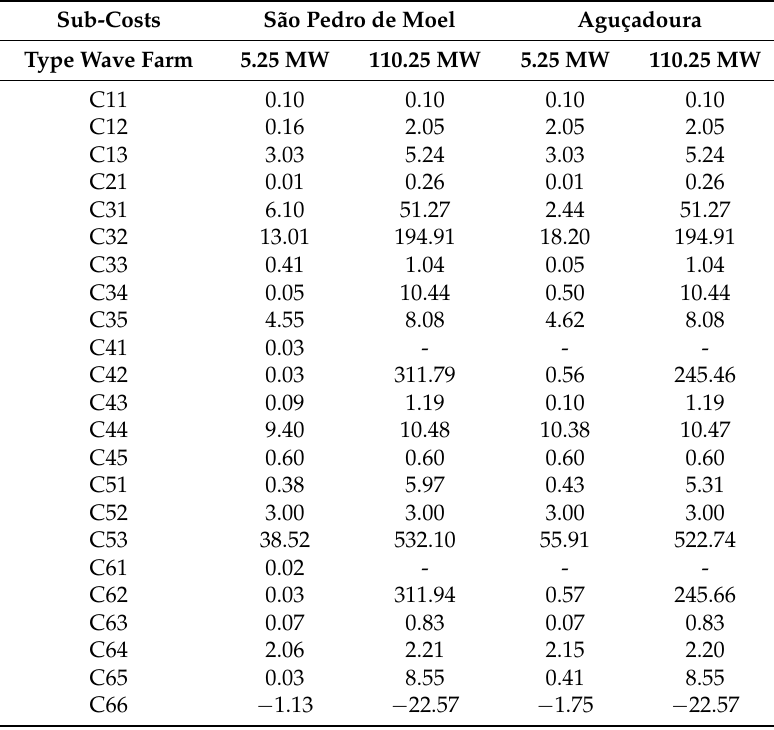
Table 8. Sub-costs of a 5.25 MW and 110.25 MW wave farm.